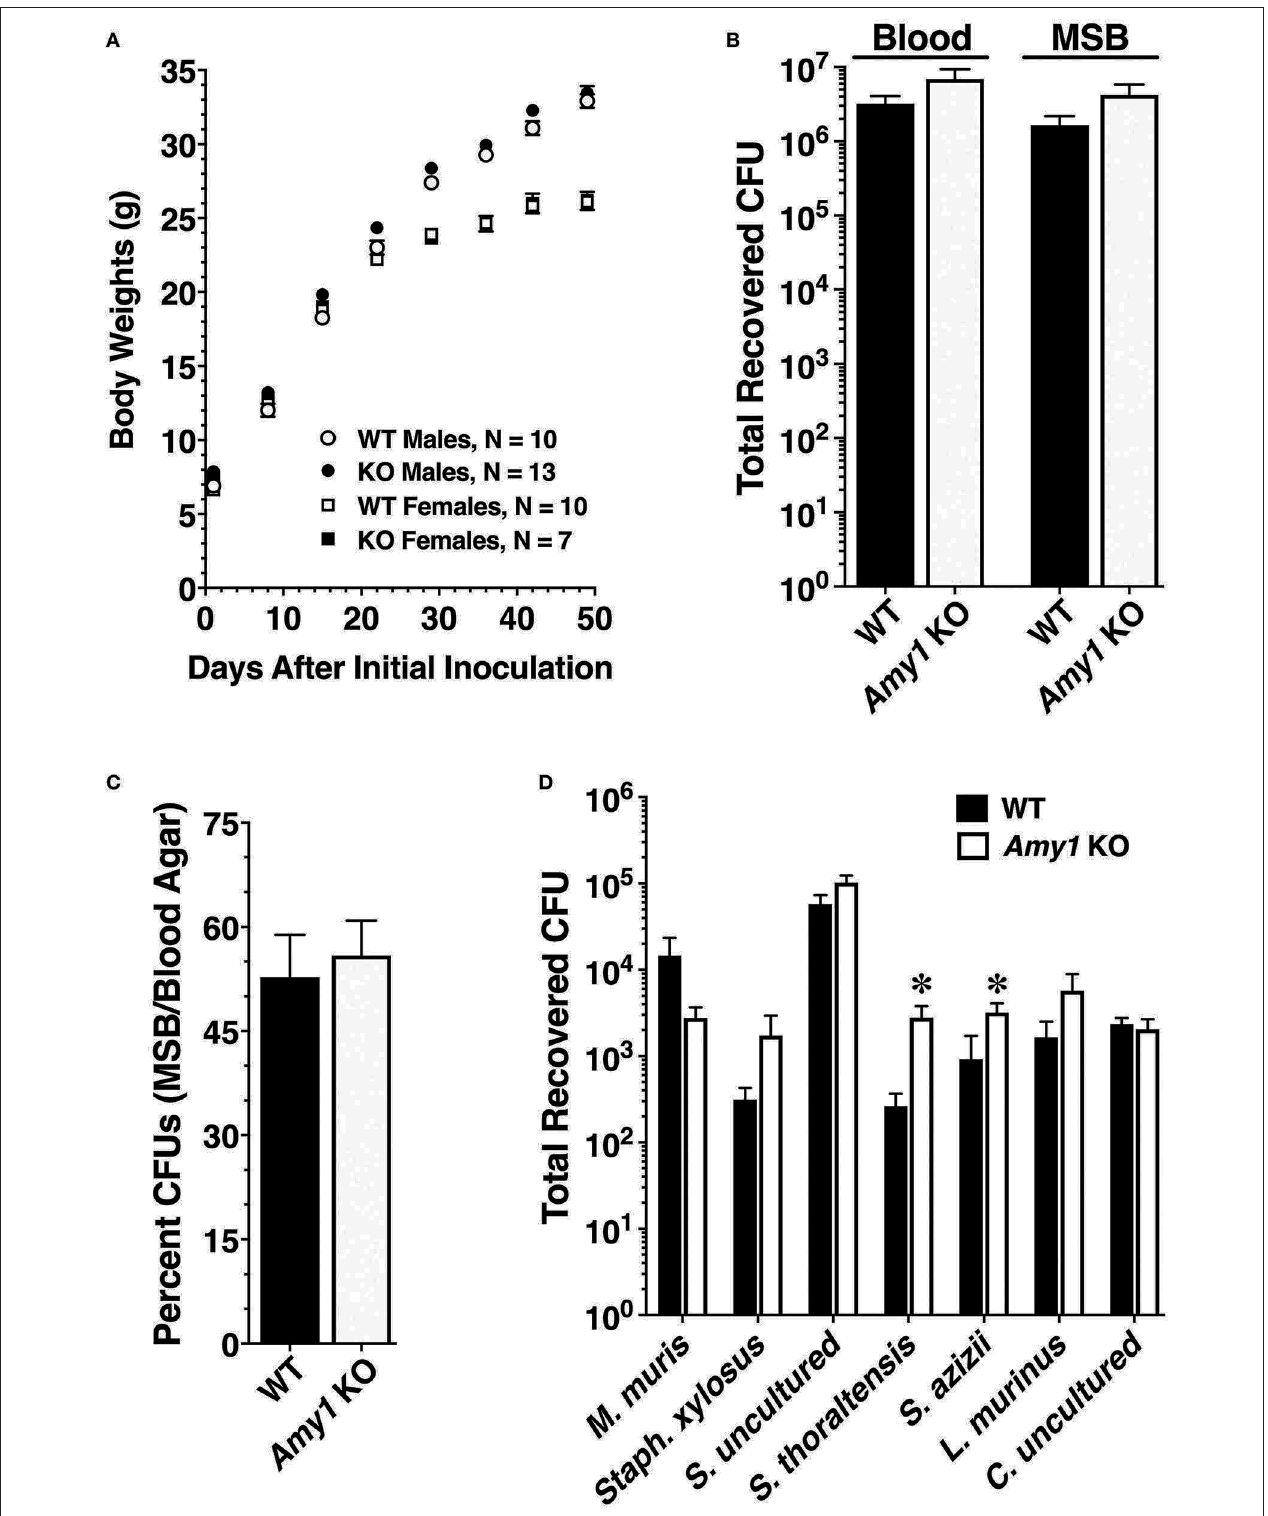
FIGURE 4 | Body weights and recoveries of cultivable microbiota from wild-type (WT) and Amy1 knockout (KO) mice in the caries experiment and comparative recoveries of autochthonous species from oral swabs. (A) Body weights (means ± SE) of male ( circles ) and female ( squares ) mice at weekly intervals during the caries experiment. (B) Recoveries of total microbiota and S. Mutans from sonicates of mandibular molars. Recoveries by CFUs (colony forming units) of S. Mutans on mitis